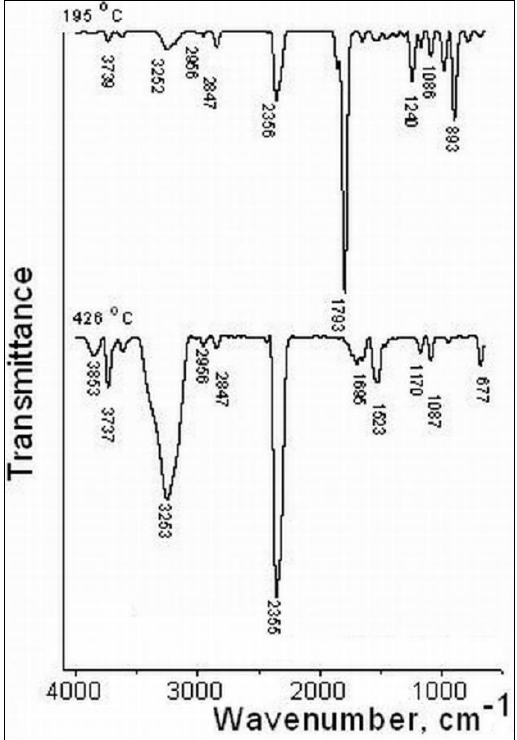
Figure 6. FTIR spectra of the evolved gases by thermal degradation of PITAU–Alg gel.